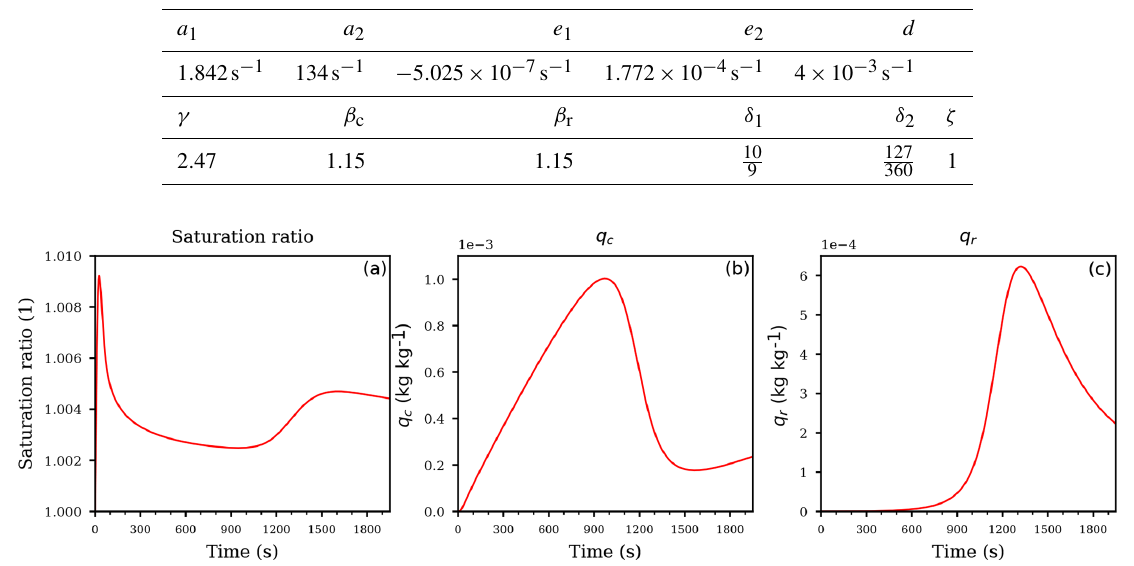
Figure 1. Temporal evolution of the saturation ratio S (a) , the cloud droplet mixing ratio q c (b) , and the rain drop mixing ratio q r (c) for the ascending air parcel with no pre-existing